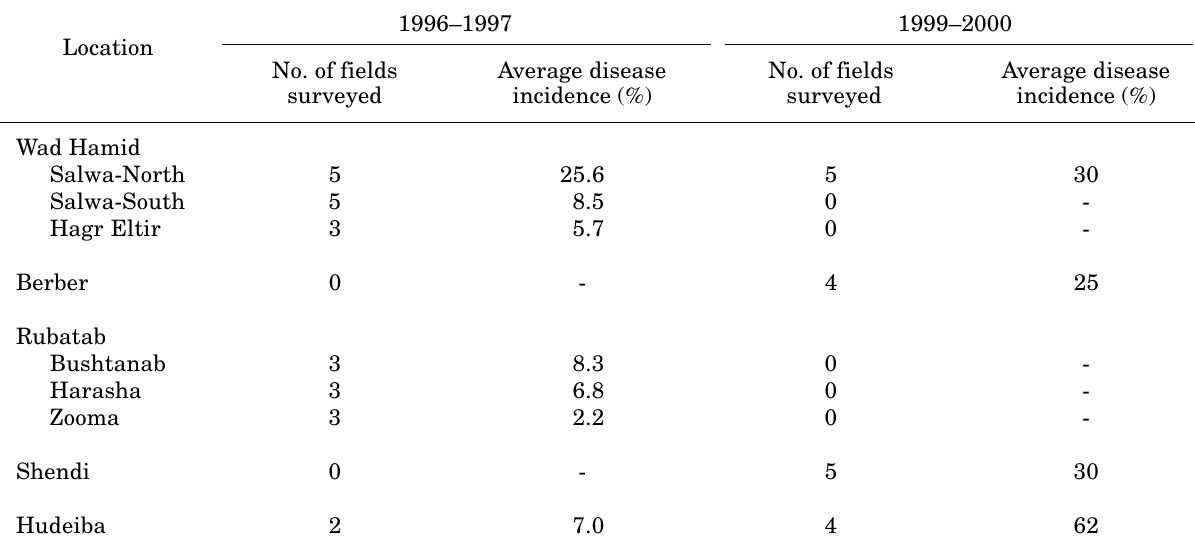
Table 1. Average incidence (%) of chickpea stunt based on symptoms observed in some randomly selected